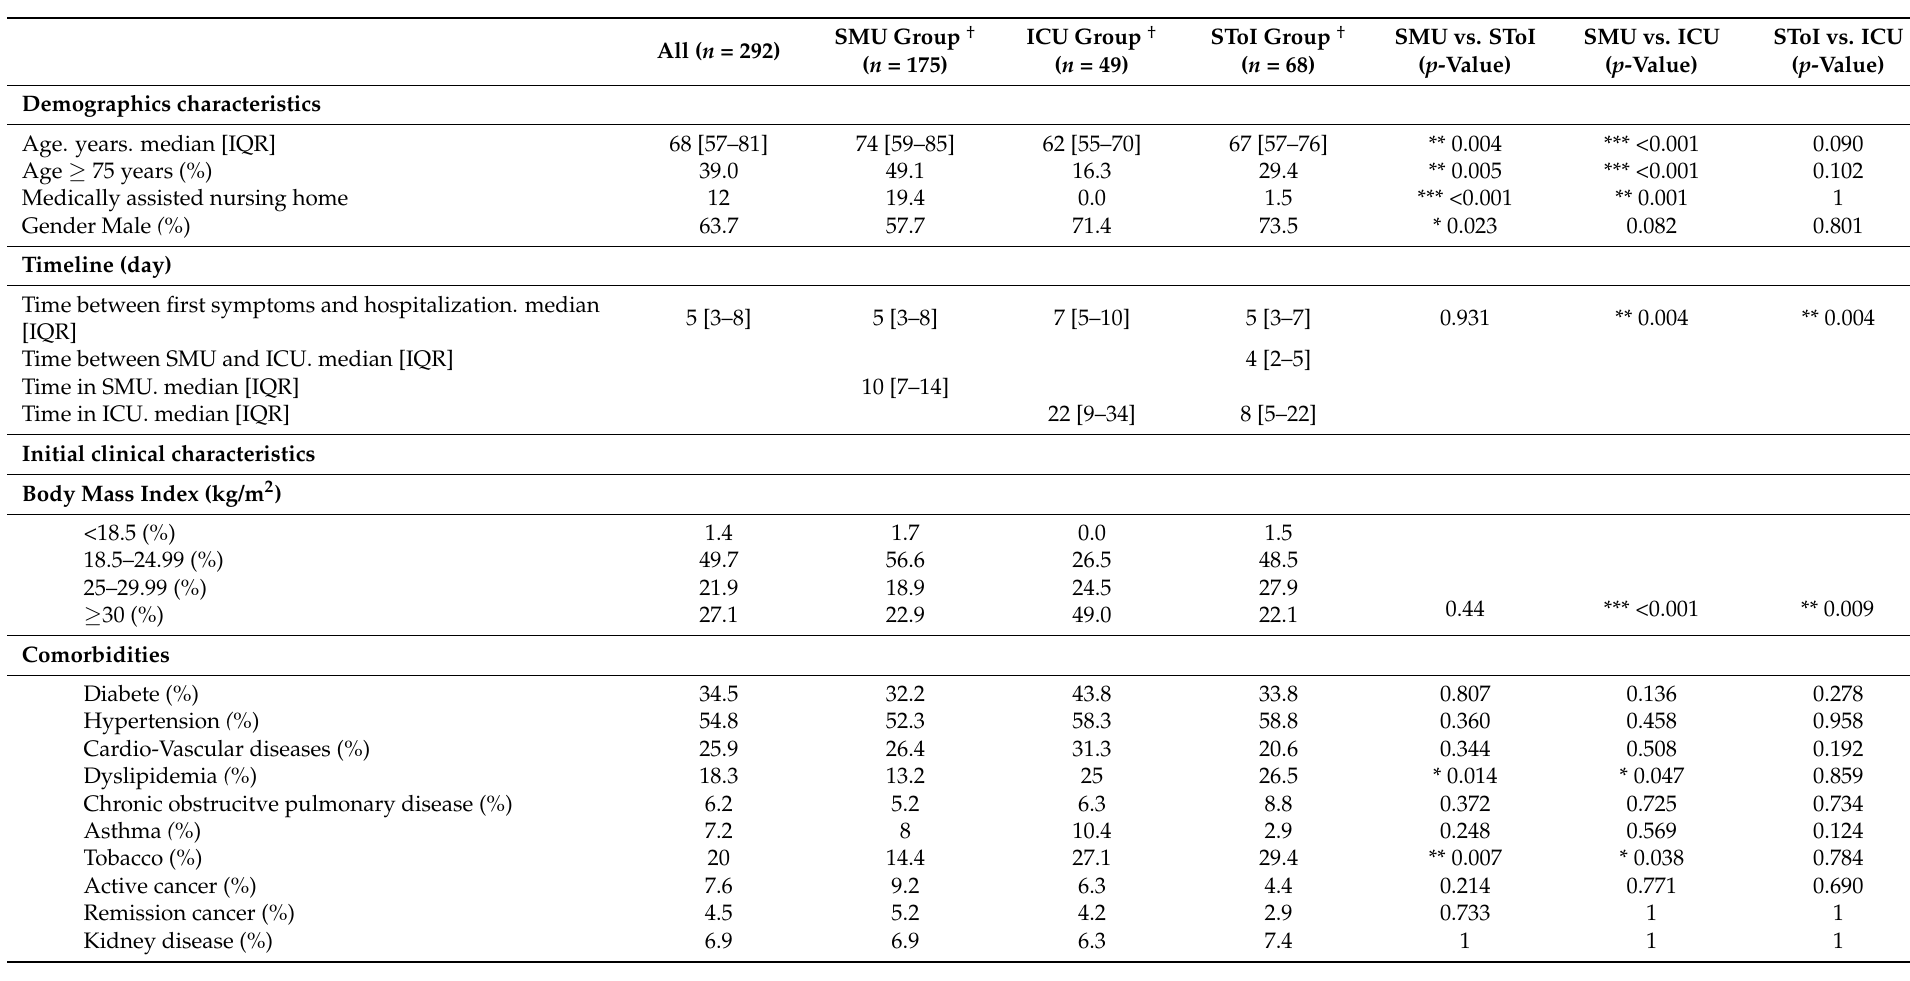
Table 1. Population’s characteristics (demographics data, important timelines, initial vital sign, income data, comorbidities, outcome data); comparison between groups for training